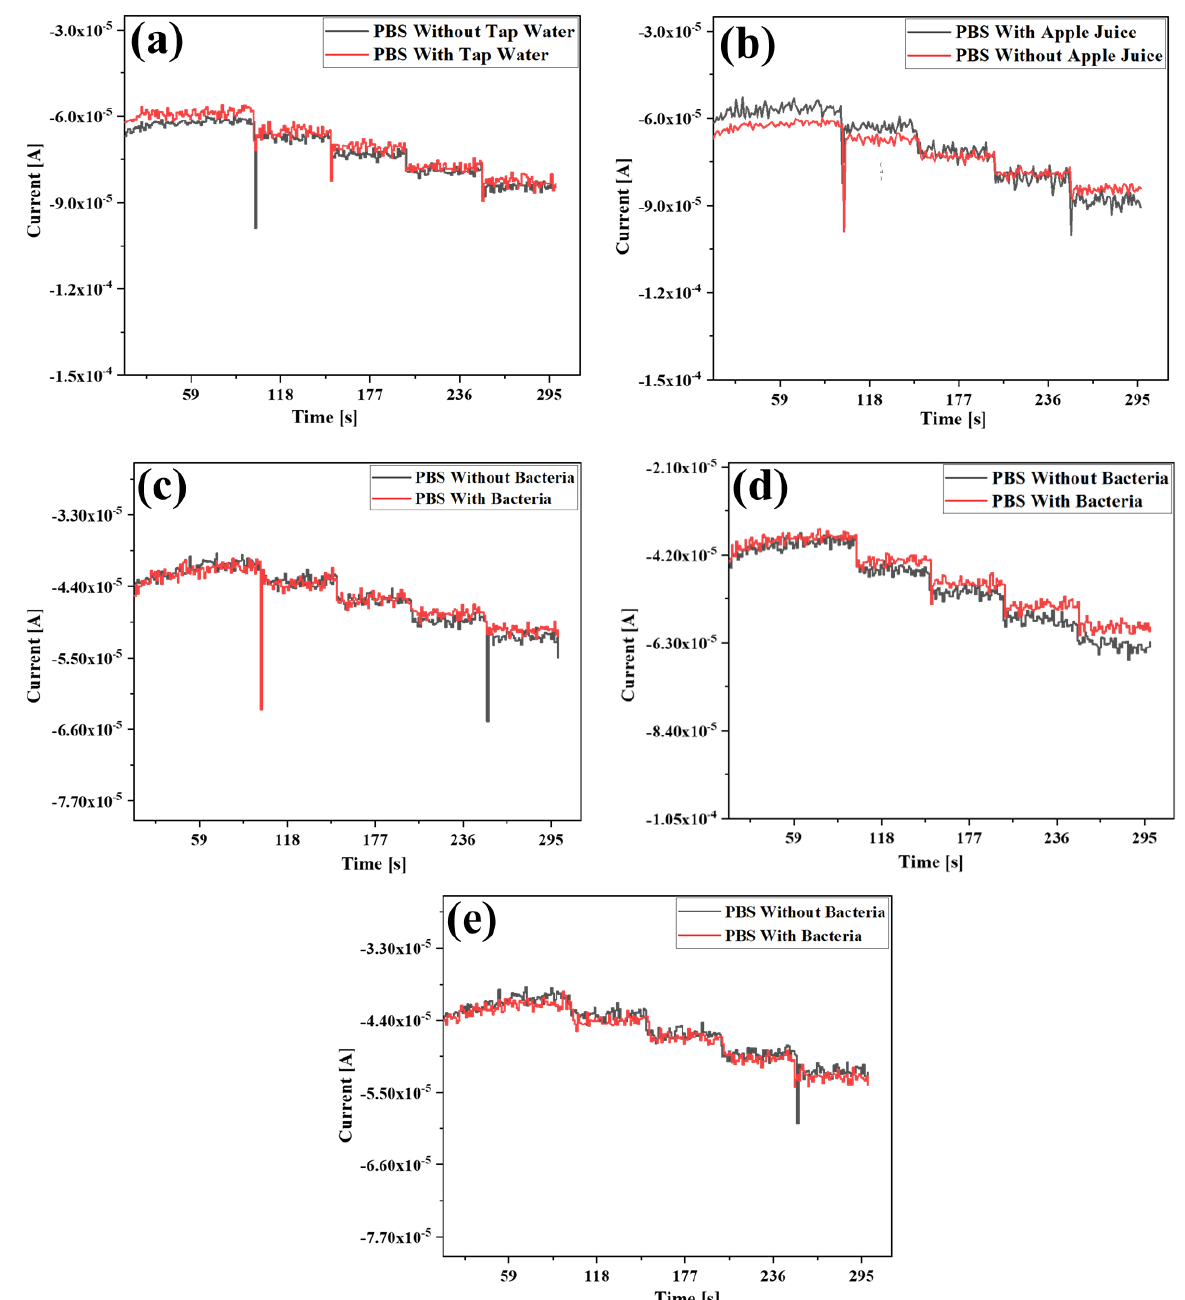
Figure 8. Amperometric responses of Au NPs/SnO 2 NFs composite electrode upon the addition of 100 μM of H 2 O 2 in electrolyte media containing ( a ) tap water; ( b ) apple juice; and upon stepwise